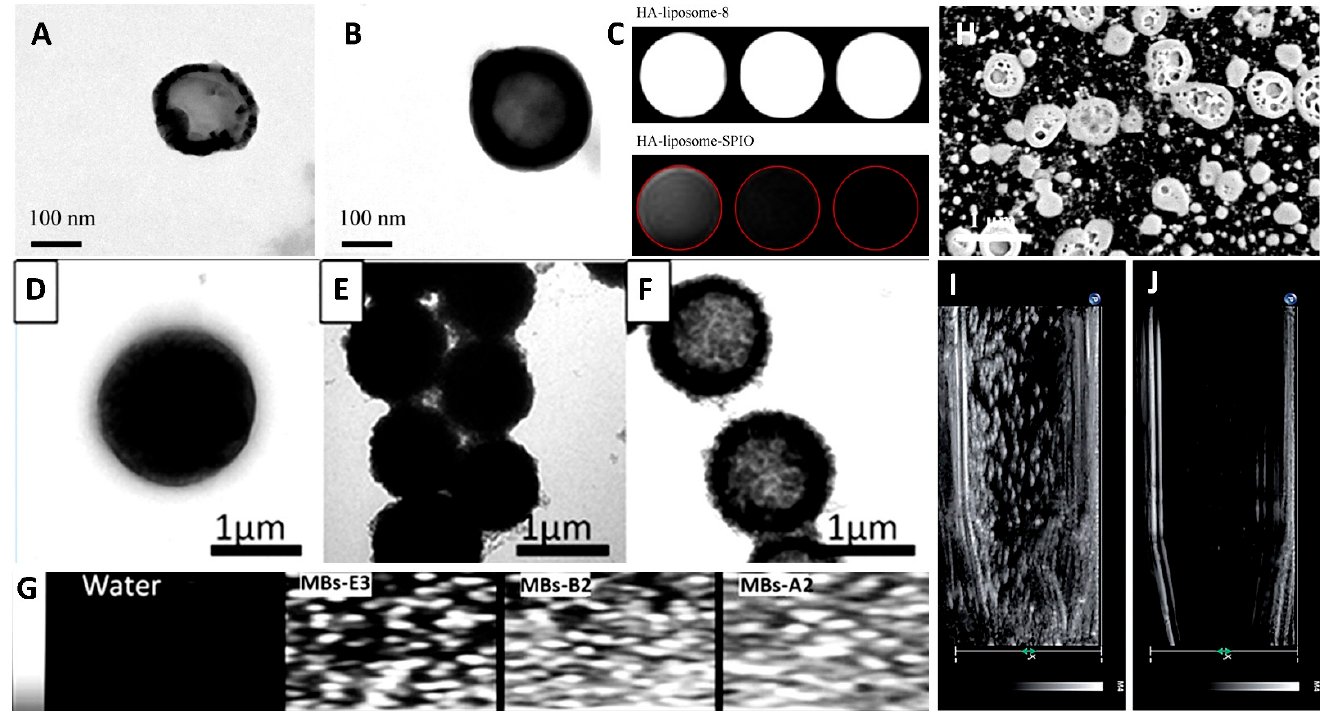
Figure 7. Different types of lipid spheres are used as contrast agents for ultrasound imaging. ( A ) Hydroxyapatite-coated liposomes and ( B ) hydroxyapatite-coated liposomes with superparamagnetic iron oxide. ( C ) MRI analysis with different liposomes. Microbubbles were modified with ( D ) polyamine salt, ( E ) magnetic polyamine salt, and ( F ) Fe 3 O 4 nanoparticles. ( G ) Ultrasonic contrast images with microbubbles. ( H ) SEM images of nanobubbles. The ultrasonic wave was treated to a break of nanobubbles for ( I ) 0 s to ( J ) 5 min. Adapted with permission from Refs. [111,112]. Copyright 2011 and 2016 Elsevier and 2018 The Royal Society of Chemistry.